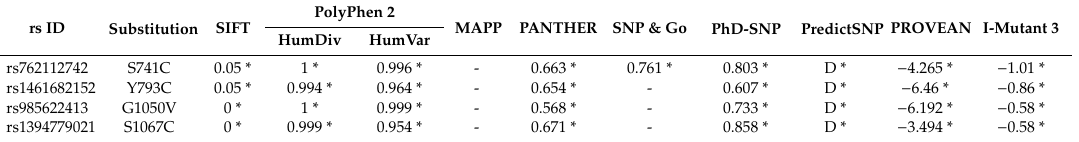
Table 1. Cumulative analysis of most deleterious variants in ATP-binding cassette transporter A1